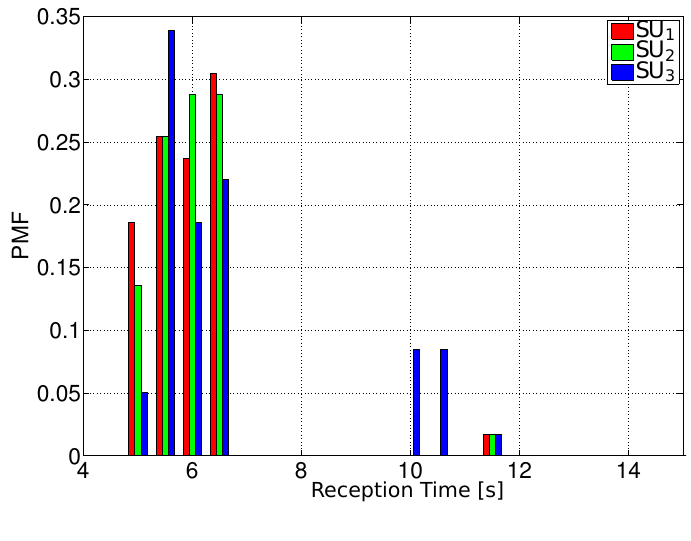
Figure 14. PMF of the archive reception time in Scenario